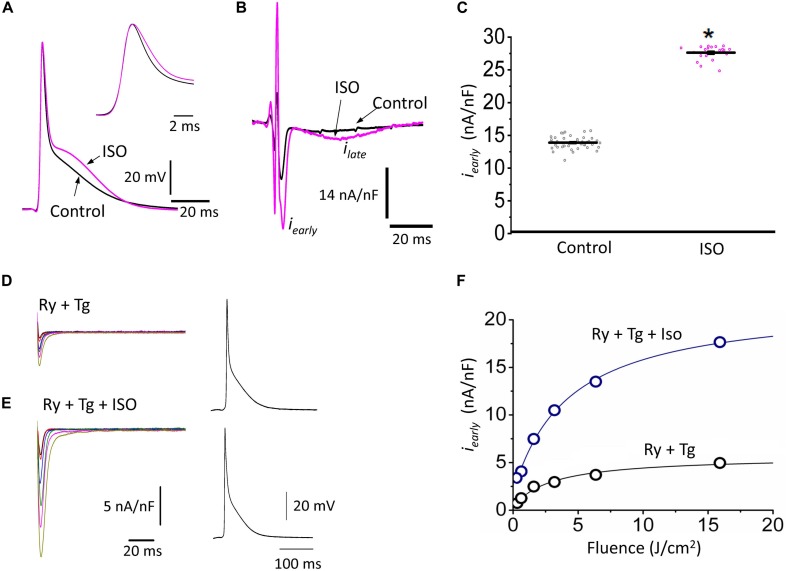
β-Adrenergic stimulation increases Ca2+-driven currents. (A) APs recorded from the epicardium using glass microelectrodes before (black) and after 500 nM isoproterenol (ISO; pink). Inset: Expanded view of the phase 0 and 1 showing the effects of isoproterenol on APD30. (B) Representative traces of Ca2+-driven currents recorded after the local photolysis of nifedipine using the Loose Patch Photolysis technique showing the iearly and ilate components upon β-adrenergic stimulation. (C) Data from the iearly component, representing the L-type Ca2+ currents, before (gray) and after isoproterenol (pink). The means ± SEM are represented as the solid horizontal lines. *p < 0.01, N = 4 hearts. (D) Representative traces of Ca2+-driven currents recorded consecutively at increasing UV energies (fluences) in control conditions in the presence of ryanodine (Ry, 10 μM) and thapsigargin (Tg, 2 μM). Right panel: Simultaneously recorded AP in the same conditions. (E) Ca2+-driven currents recorded consecutively at increasing UV energies (fluences) with isoproterenol in the presence of ryanodine (Ry, 10 μM) and thapsigargin (Tg, 2 μM). Right panel: Simultaneously recorded AP in the same conditions. (F) Peak values of iearly as a function of the fluence, before (black) and after isoproterenol (blue) in the presence of Ry and Tg.